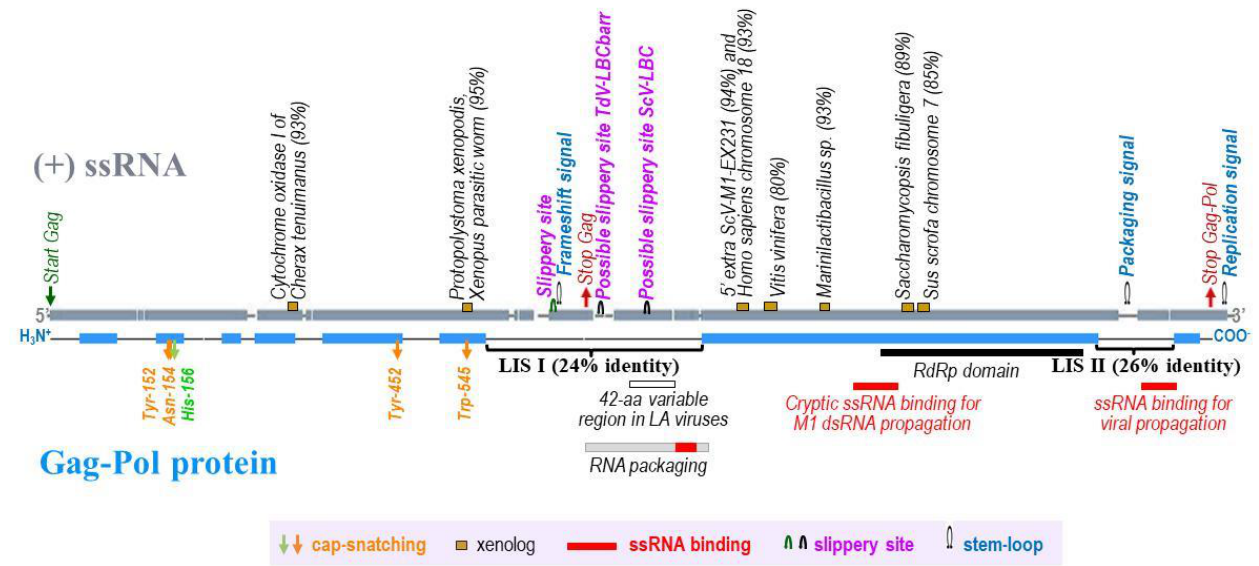
Figure 1. A schematic representation of TdV-LBCbarr (ssRNA and Gag-Pol) showing the two stretches of low sequence identity with Gag-Pol of ScV-LBC1-original: stretch I (LIS I) and stretch II (LIS II). Grey (ssRNA) and blue (Gag-Pol protein) shaded regions are areas of significant identity (above 50% in windows of 50 nucleotides or 20 amino acids in length) between TdV-LBCbarr2 and ScV-LBC1-original genomes. Global alignment was done using Clone Manager 7.11. Scoring matrix: Linear (Mismatch 2, OpenGap 4, ExtGap 1 for cDNA; and BLOSUM 62 for protein). Relevant RNA codons and motifs of the viral genome are displayed above the (+)ssRNA, as well as stretches (≥30 nucleotides) showing high local identity (≥80%) with xenolog sequences of cellular organisms (percentage of identity is in parenthesis). Relevant amino acids for cap-snatching and RdRp domain are shown below Gag-Pol, as well as the location of 42-amino acid variable region, ssRNA binding regions, and RNA packaging region previously described in yeast LA viruses.